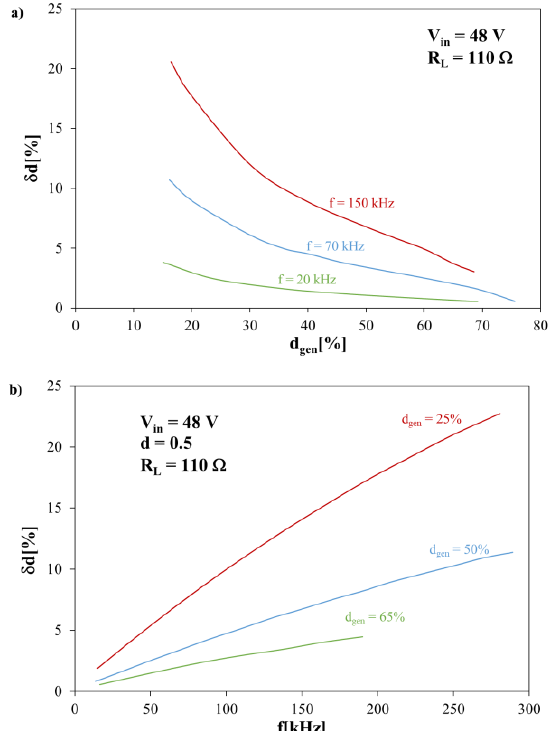
Figure 13. Measured values of the relative error in determining the duty cycle of the signal between the IGBT output terminals as a function of the duty cycle of the control signal ( a ) and the frequency of the signal controlling this transistor ( b ).